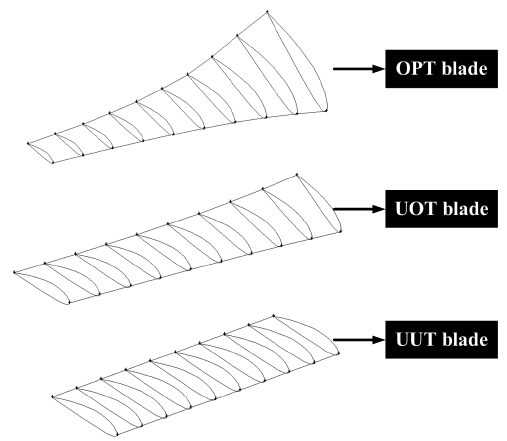
Figure 5. Three test blade models for wind tunnel